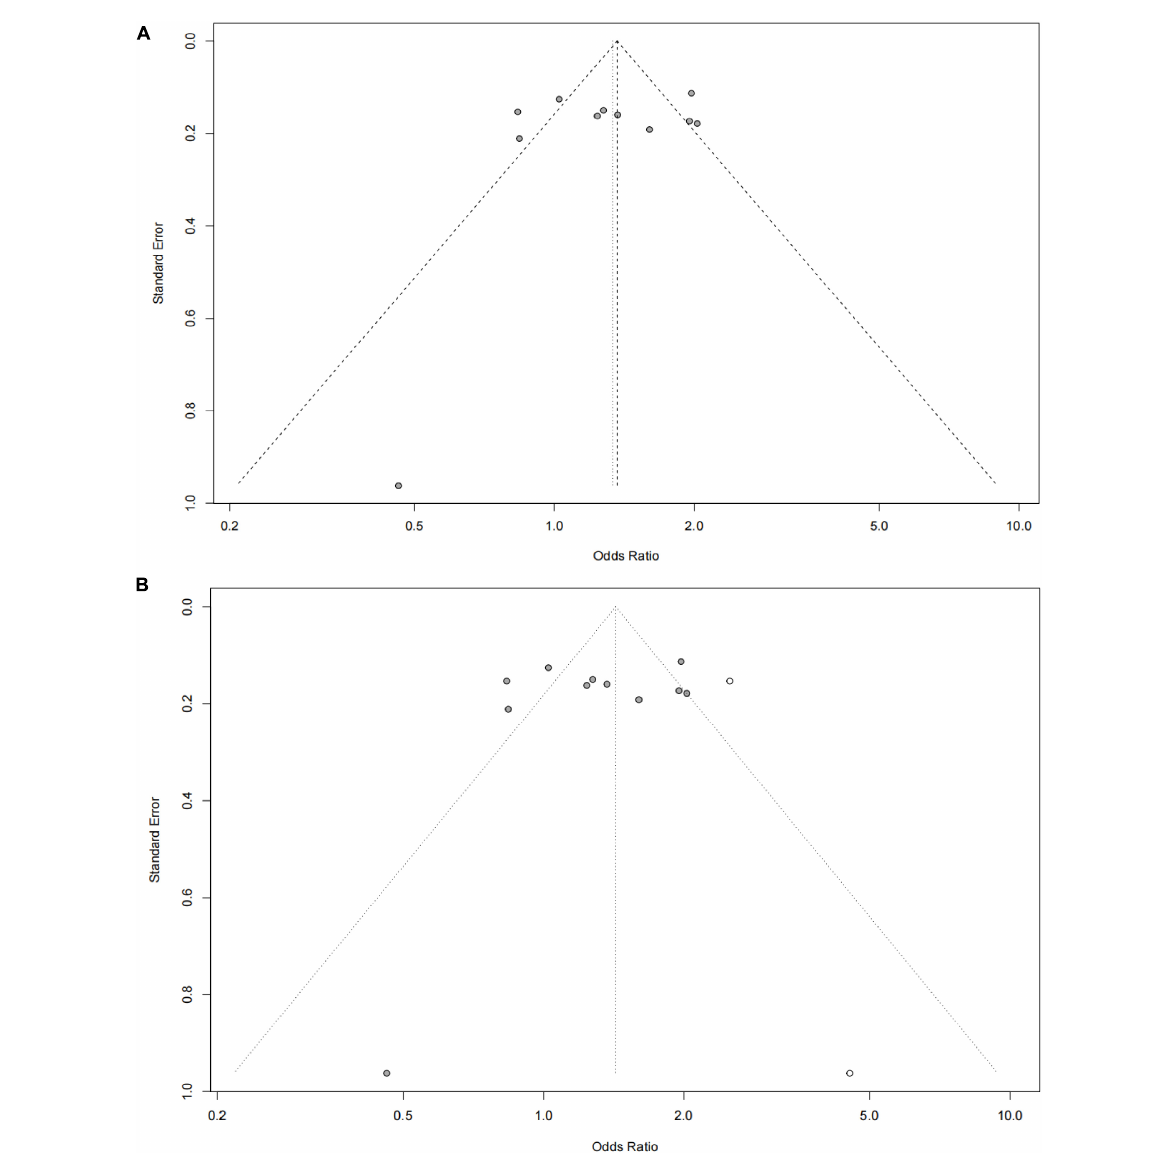
FIGURE4 Funnel plot for publication bias analysis of rs9349407 polymorphism in Alzheimer’s disease (AD) using the allele model. (A) An inverted funnel plot of selected studies on the relationship between rs9349407 and Alzheimer’s disease. (B) A completely symmetric inverted funnel plot of the two studies was filled on the right side of 4A based on the shear complement